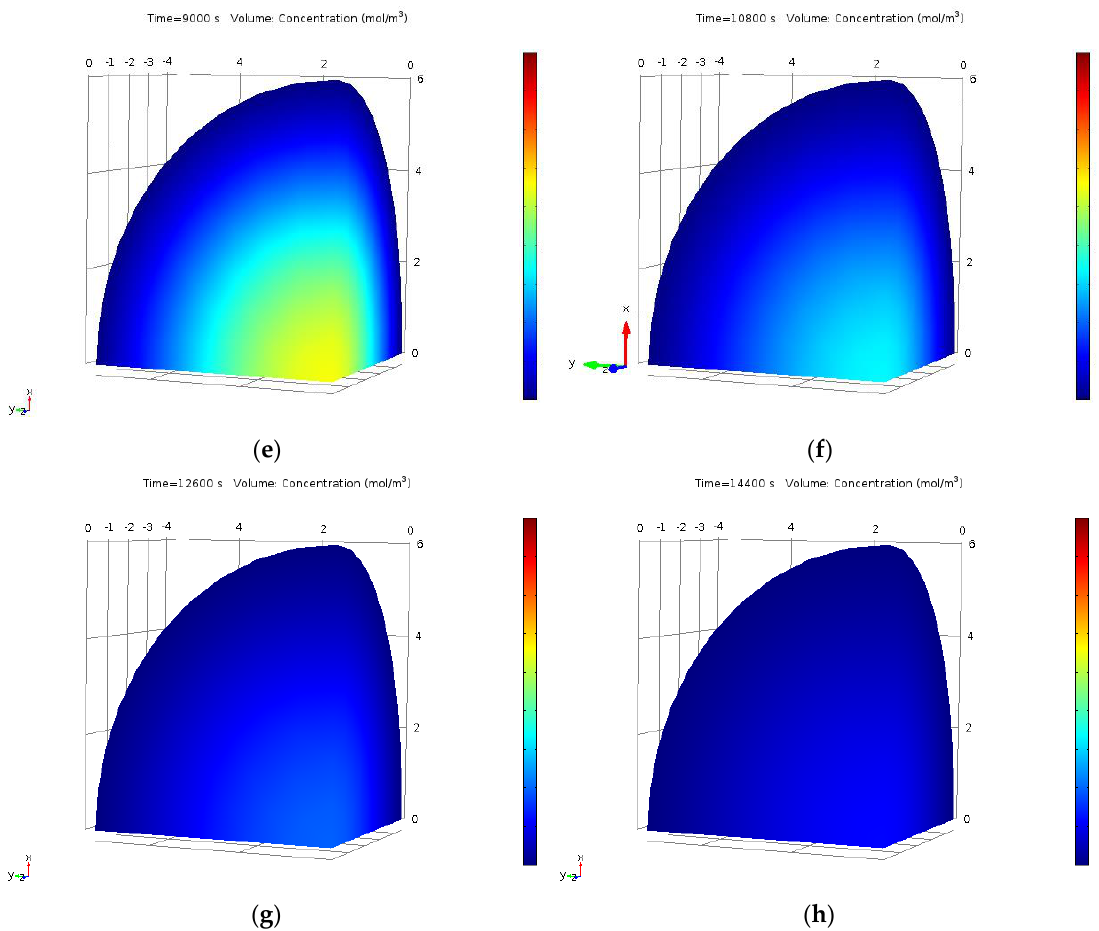
Figure 6. ( a – h ) show a gradual migration of the extracted solute from the centre of the solid matrix to the surface. ( a ) Concentration values at time t = 30 min. ( b ) Concentration values at time t = 60 min. ( c ) Concentration values at time t = 90 min. ( d ) Concentration values at time t = 120 min. ( e ) Concentration values at time t = 150 min. ( f ) Concentration values at time t = 180 min. ( g ) Concentration values at time t = 210 min. ( h ) Concentration values at time t = 240 min. Theoretically, the finite element model, as shown in Figure 6a–h, indicates that even at the end of the extraction process, the concentration throughout the solid matrix is not uniform.